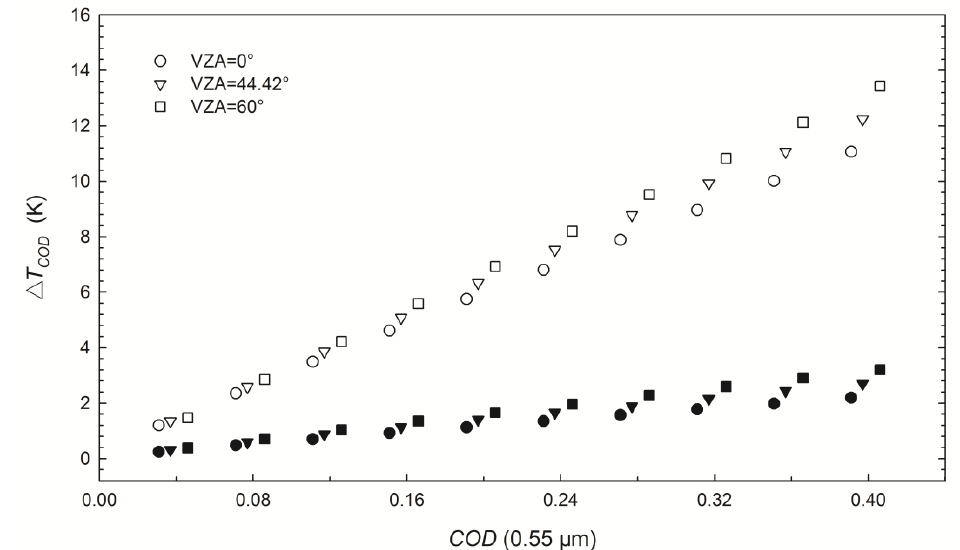
Figure 5. RMSEs between the LST clear-sky and LST COD (hollow symbols) and the RMSEs between the LST clear-sky and LST AC (solid symbols) for three VZAs. LST COD and LST clear-sky are those retrieved from Data-cirrus and Data-clearsky using the GSW algorithm, respectively. LST AC are the LSTs of LST COD minus the correction term k * COD .